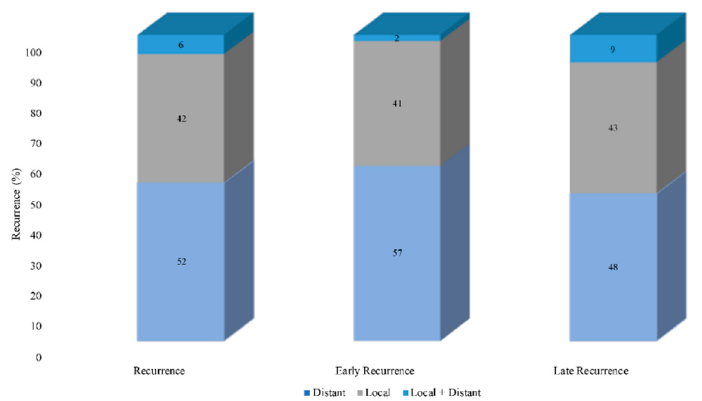
Figure 4. Distribution of the primary site of recurrence (local, distant, local + distant) in patients with a pNET, stratified into those with early versus late recurrence.